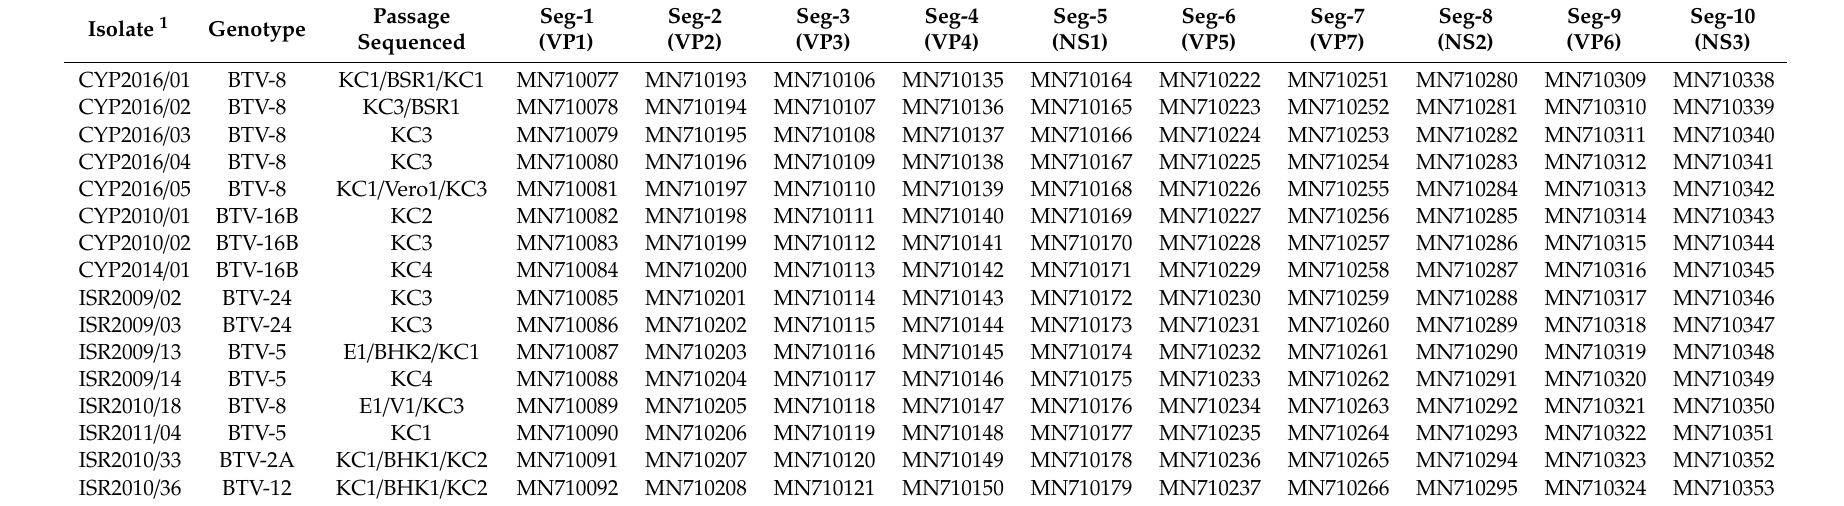
Table 1. BTV isolates sequenced during this study and associated Genbank accession number for the genome